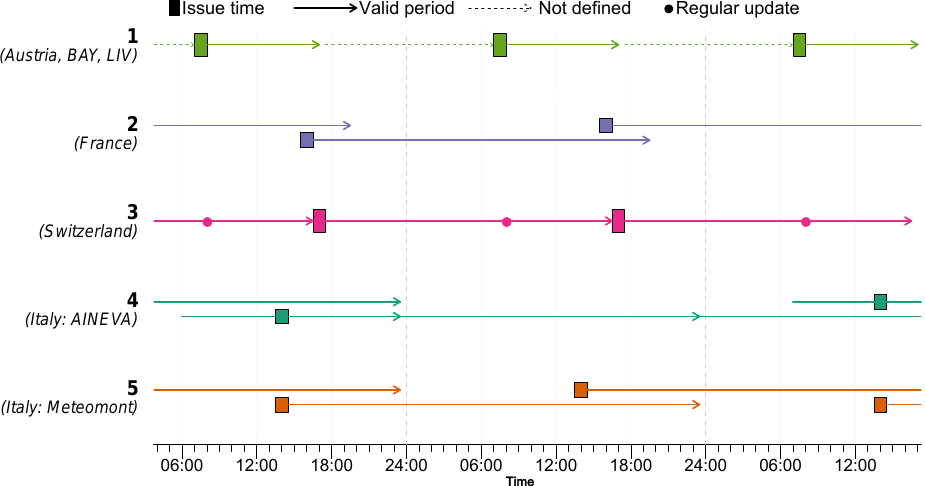
Figure 2. Schematic summary of the different bulletin publication frequencies, issuing times, and periods of validity. In special circumstances, updates during the morning were possible in most forecast centers. Particularly for Italy (AINEVA), it is of note that the exact publication times, valid periods, and publication frequencies may differ between forecast centers, but changes may also have been introduced from one season to the next. Forecast centers are labeled according to Table